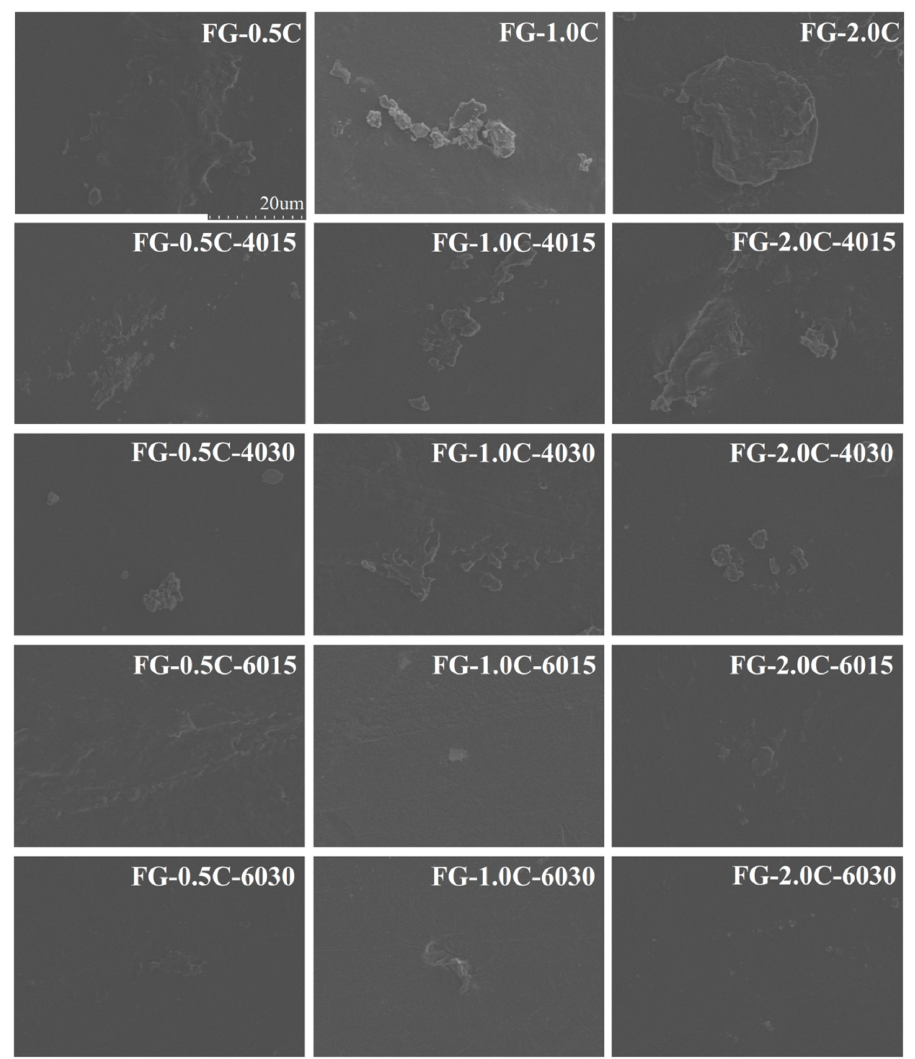
Figure 4. Effect of sonication on scanning electron microscope (SEM) micrographs (magni fi cation: Figure 4. E ff ect of sonication on scanning electron microscope (SEM) micrographs (magnification: 2000 × ) of surfaces of flaxseed gum films incorporated with